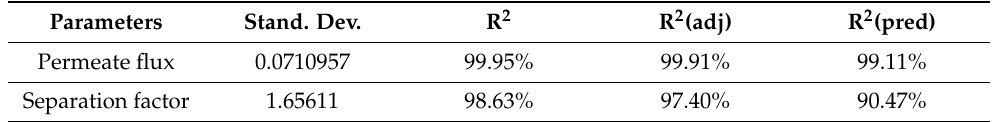
Table 7. Model summary for benzene permeate flux and separation factor.